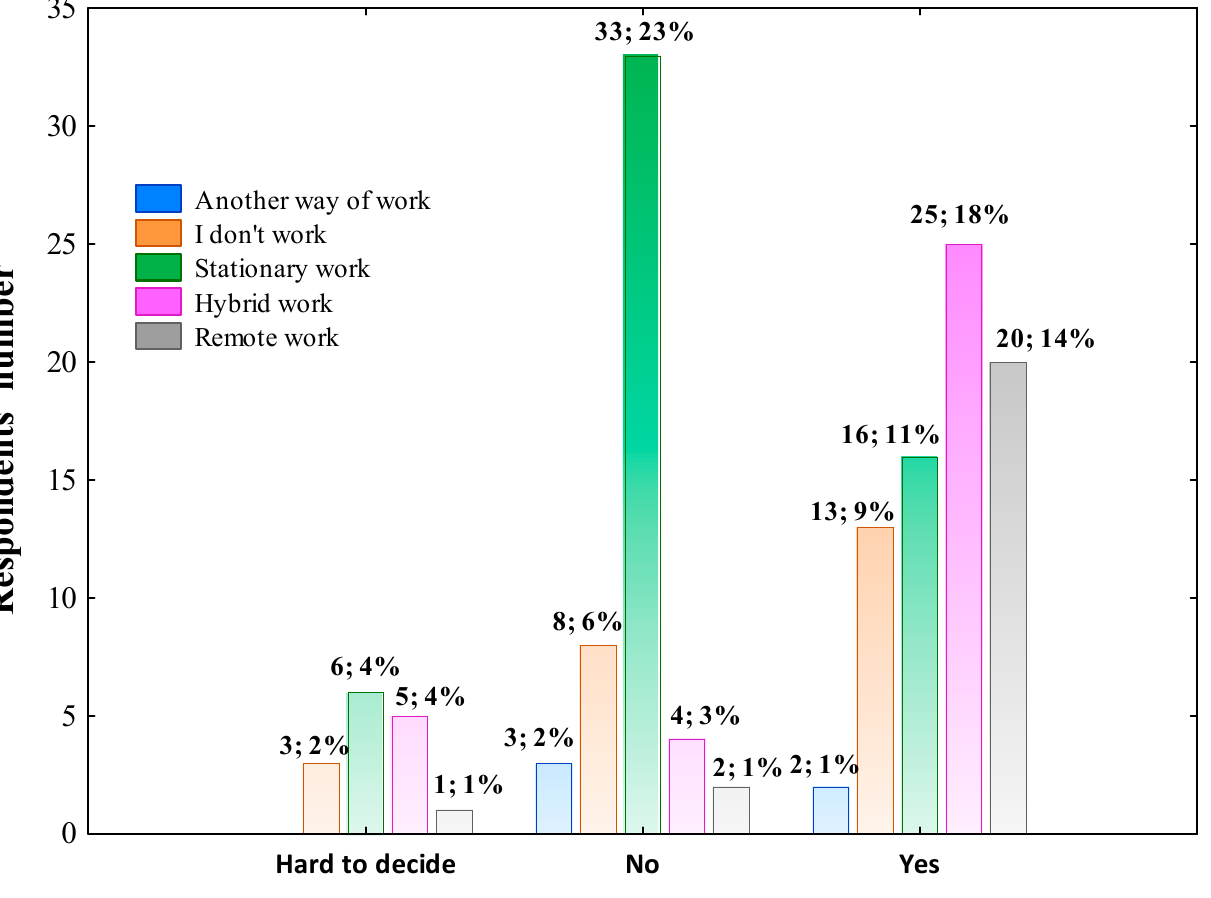
Table 6. Multivariate linear regression analysis of the association between age, gender, education level, living place, professional work mode and daily lifestyle change.